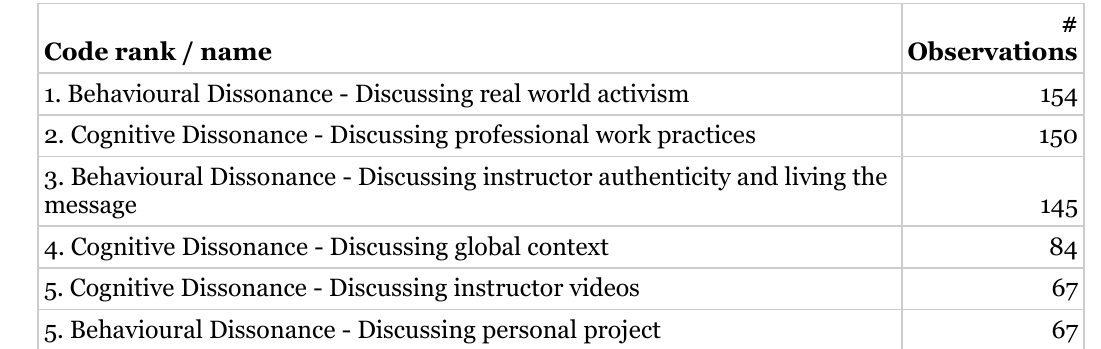
Top Five Dissonance Codes